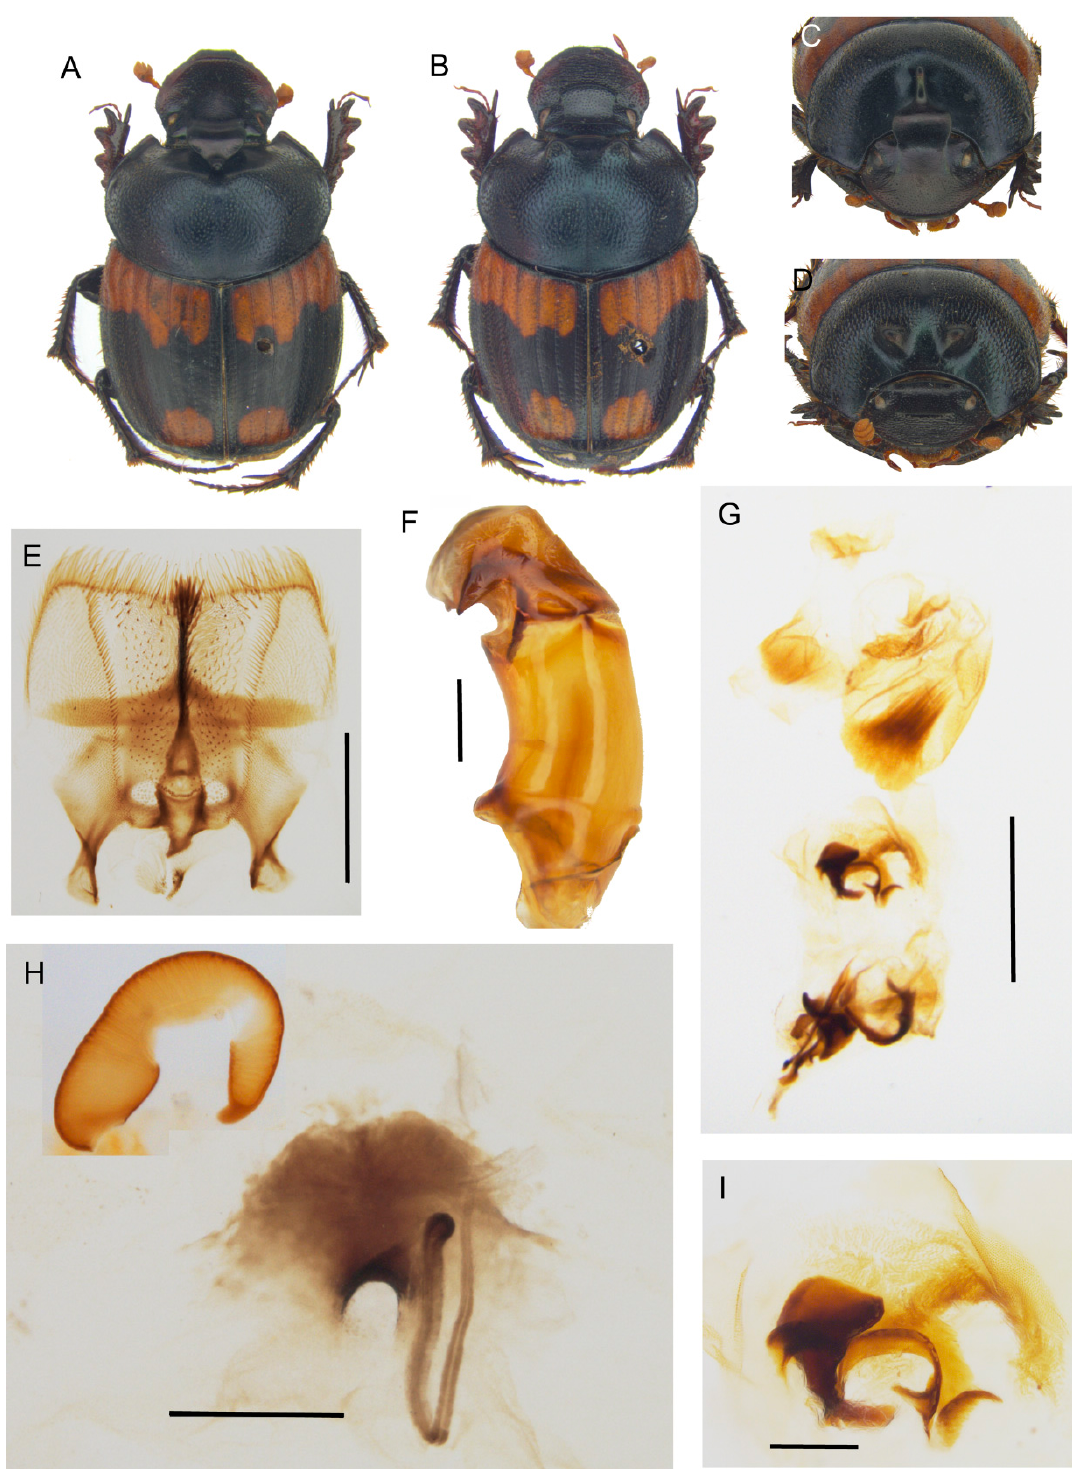
Figure 11. Features of Tiaronthophagus rolandoi n.sp . (A) : Male facies (above). (B) : Female facies (above). (C) : Male facies (frontal view). (D) : Female facies (frontal view). (E) : Epipharynx, scalebar = 0.5 mm. (F) : Male genitalia, phallobase and parameres, scalebar = 0.5 mm. (G) : Male genitalia, endophallus, scalebar = 1.0 mm. (H) : Female genitalia, vagina and receptaculum seminis, scalebar = 0.3 mm. (I) : Male genitalia, lamella copulatrix, scalebar = 0.2 mm.